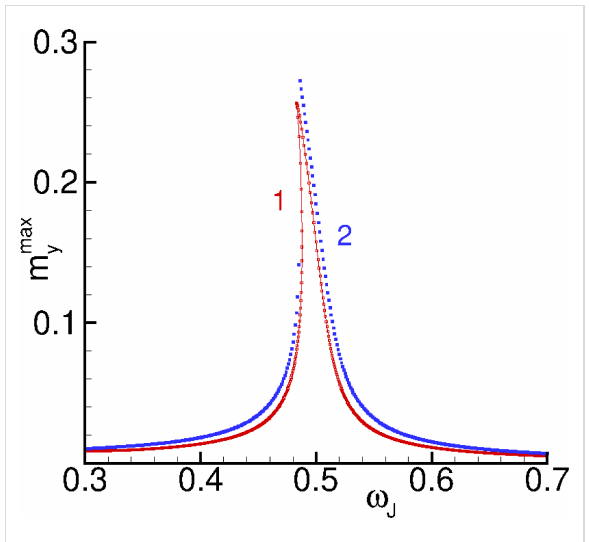
Figure 8: Numerically (red curve) and analytically (blue curve) calcu- lated amplitude dependence of m y .